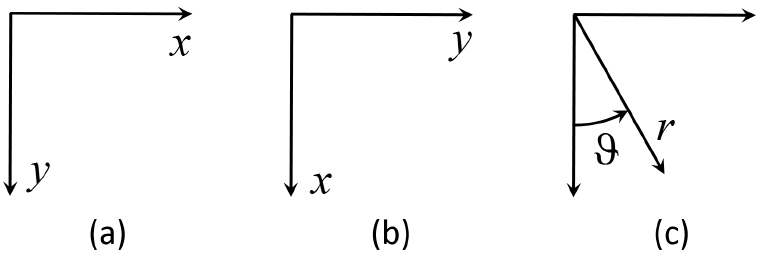
Figure 1. Brachistochrone Coordinate Systems: ( a ) classic cartesian coordinate system, ( b ) modified cartesian coordinate system, and ( c ) polar coordinate